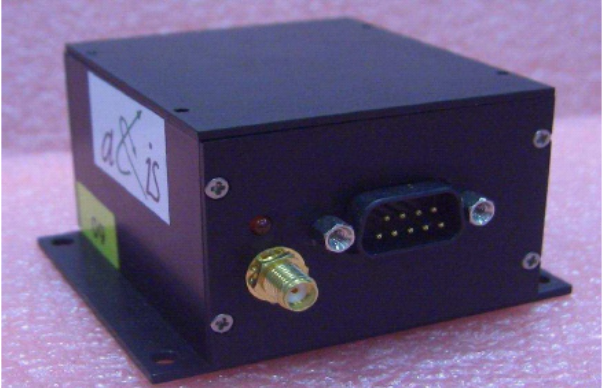
Figure 3. The AXIS-AIS402 inertial measurement